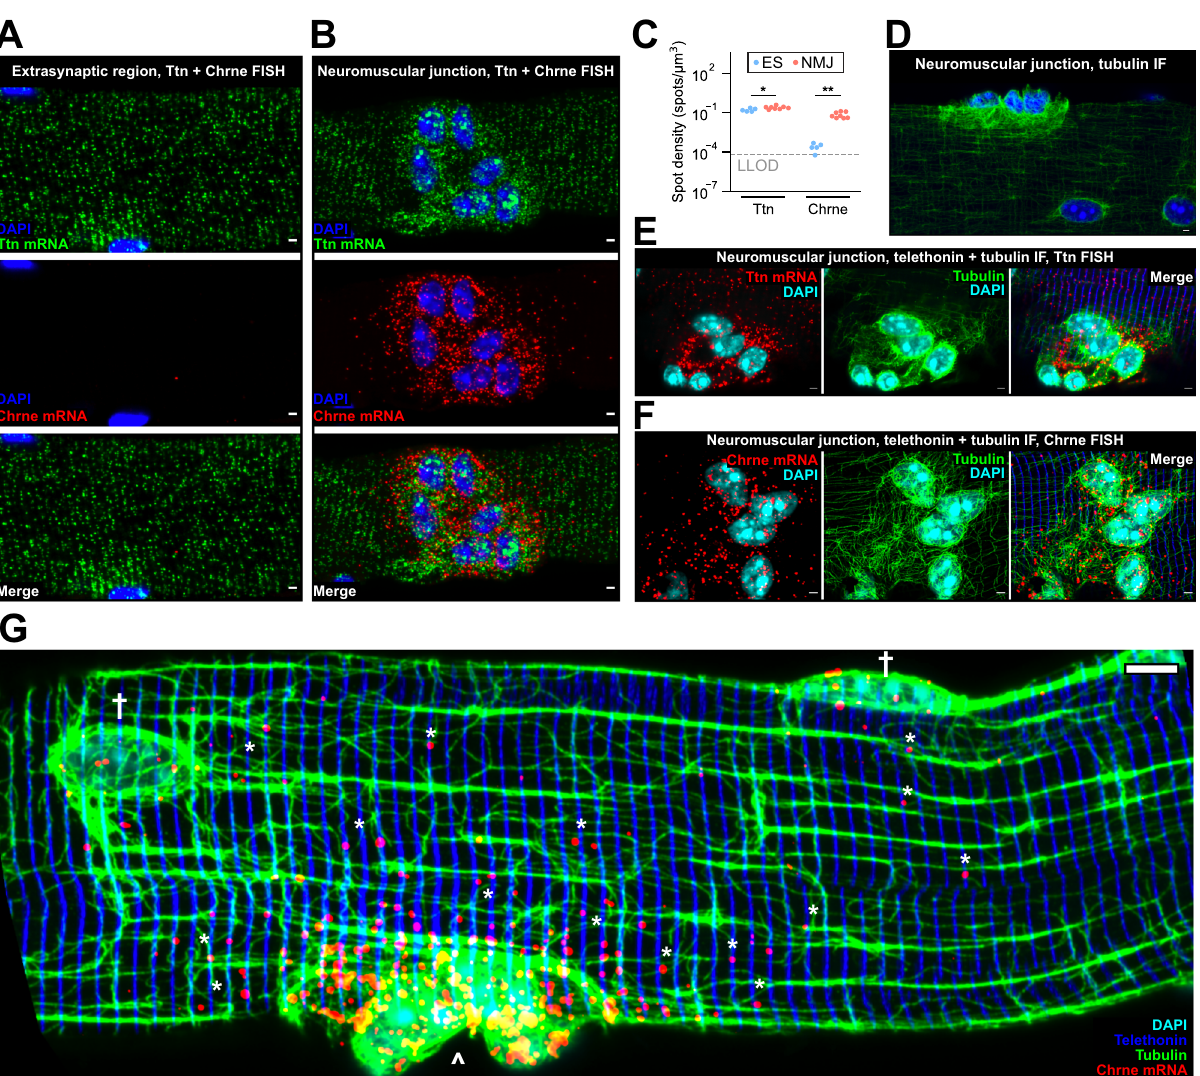
Fig. 3 Chrne RNA produced in postsynaptic nuclei is con fi ned to the NMJ region. A Representative image of FISH for Ttn (green) and Chrne (red) RNA in an extrasynaptic region of an isolated EDL myo fi ber. Scale bars: 2 µ m. B Representative image of FISH for Ttn (green) and Chrne (red) RNA in the NMJ of an isolated EDL myo fi ber. Scale bars: 2 µ m. C Quanti fi cation of RNA density for Ttn and Chrne RNAs in extrasynaptic (blue) and NMJ regions (red) of myo fi bers. Extrasynaptic regions: n = 5 myo fi bers; NMJ regions: n = 8 myo fi bers. * p < 0.05, ** p < 10 − 4 . Two-sided Mann – Whitney U test. Dotted line indicates lower limit of detection (LLOD). D Tubulin IF in NMJ region of an isolated myo fi ber. Scale bars: 2 µ m. E IF/FISH co-labeling of Ttn RNA (red), tubulin protein (microtubules, green), and telethonin protein (Z-disks, blue) at the NMJ of an isolated myo fi ber. Scale bar: 2 µ m. F IF/FISH co-labeling of Chrne RNA (red), tubulin protein (microtubules, green), and telethonin protein (Z-disks, blue) at the NMJ of an isolated myo fi ber. Scale bar: 2 µ m. G Large fi eld of view image of IF/FISH co-labeling of Chrne RNA (red), tubulin protein (microtubules, green), and telethonin protein (Z-disks, blue). * indicates Chrne RNAs in the extrasynaptic myo fi ber neighboring the NMJ. † indicates extrasynaptic nuclei containing Chrne mRNAs. ^ indicates NMJ region containing high concentration of Chrne RNA. Scale bar: 10 µ